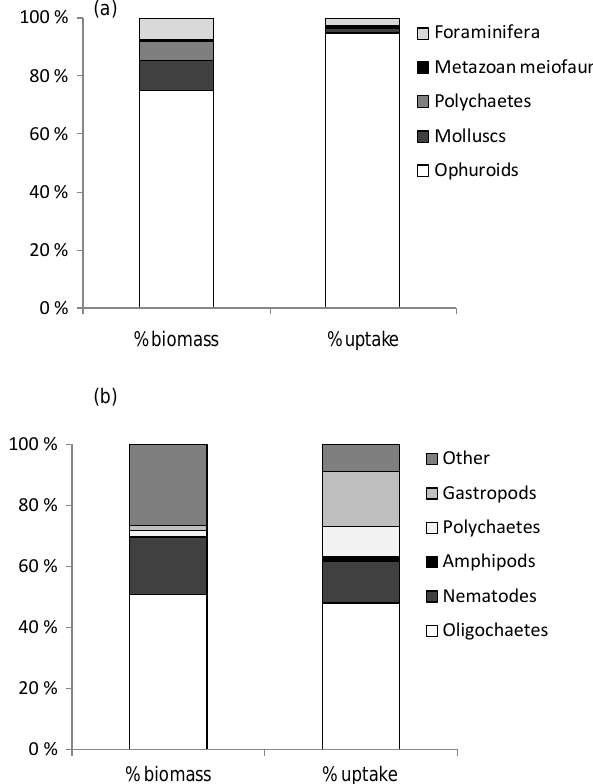
Figure 3. Taxa responsible for biomass and C uptake in (a) Loch Etive and (b) the Ythan sand Figure 3.Taxa responsible for biomass and C uptake in a) Loch Etive, and b) the Ythan sand flat. 15